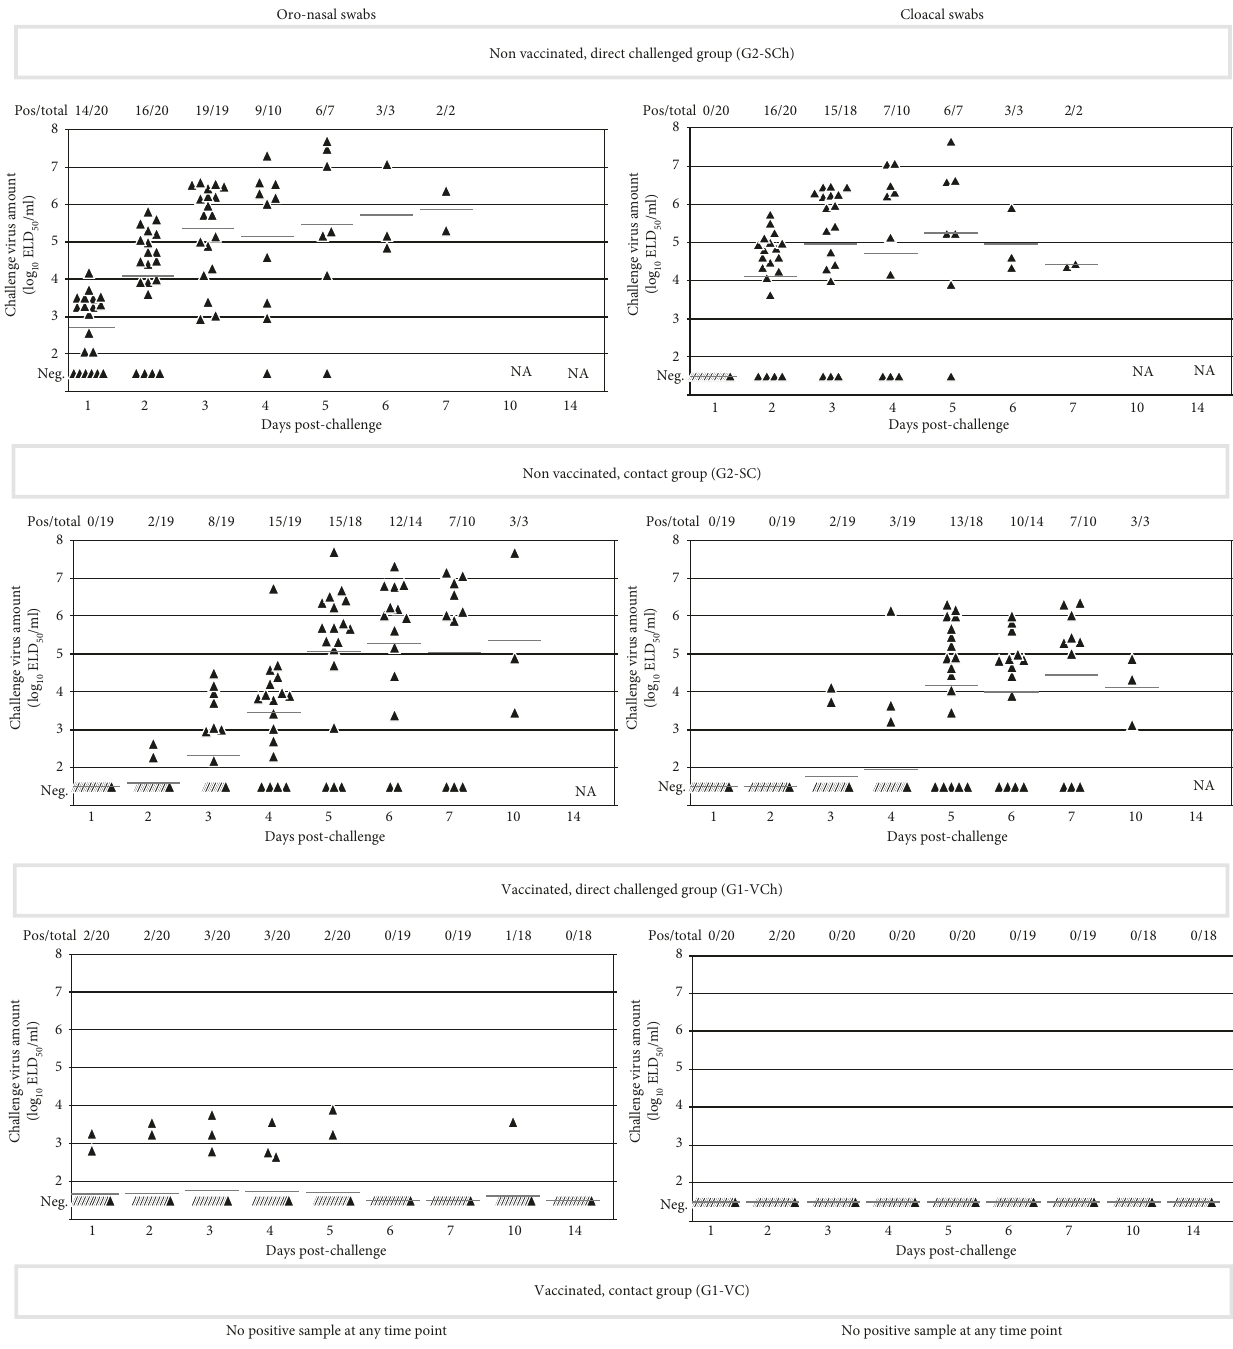
Figure 4: Oronasal and cloacal shedding by broilers. AIV load of swab samples measured by qRRT-PCR is presented as log scatterplot; horizontal bars represent group mean value for each date. For calculation of mean, negative samples were given a value of 1.5 log ELD /ml. Contact challenged groups (G1-VC and G2-SC) were comingled with the direct-challenged control group (G1-VCh and G2-SCh) 50 from 8 hours postchallenge. Sampling date refers to the time after direct